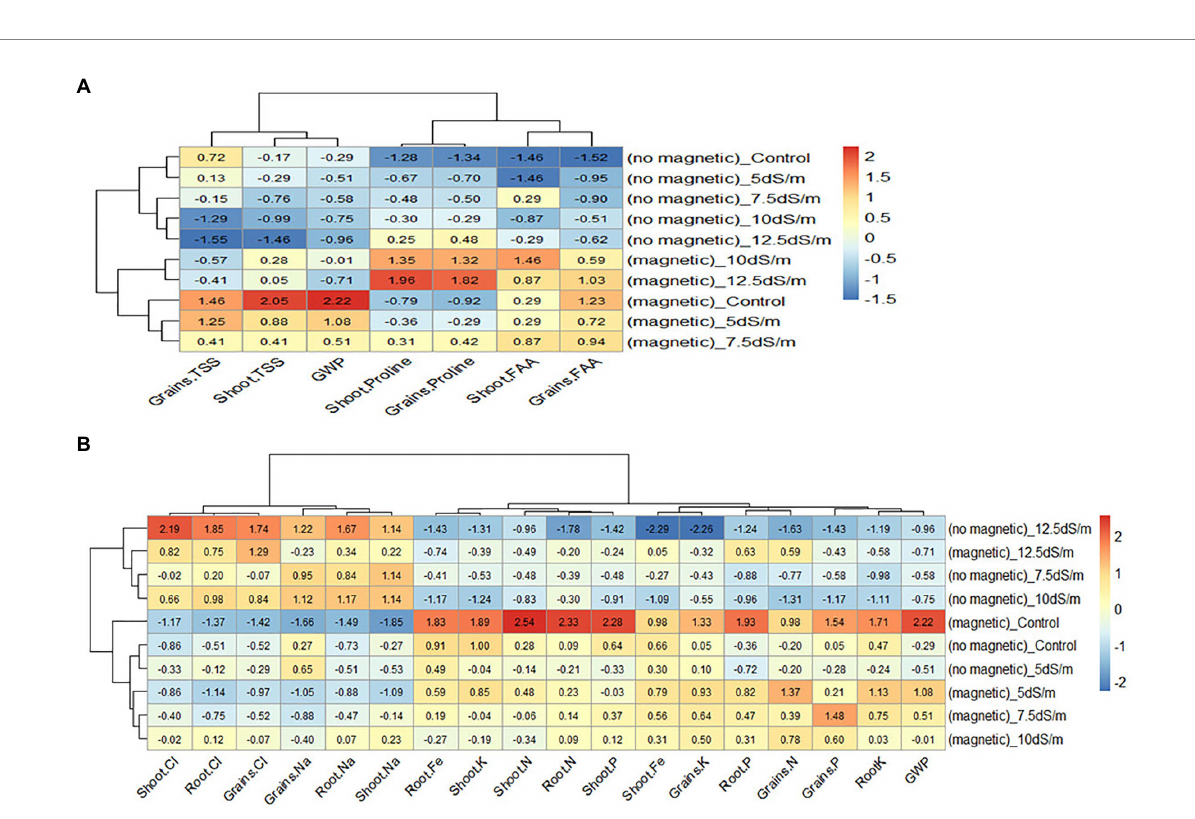
FIGURE 4 Heatmap of the relationship between the treatments and related parameters. The relationship between the treatments and the studied (A) traits and (B) nutrients. TSS, total soluble sugars; GWP, grain yield/plant; FAA, free amino